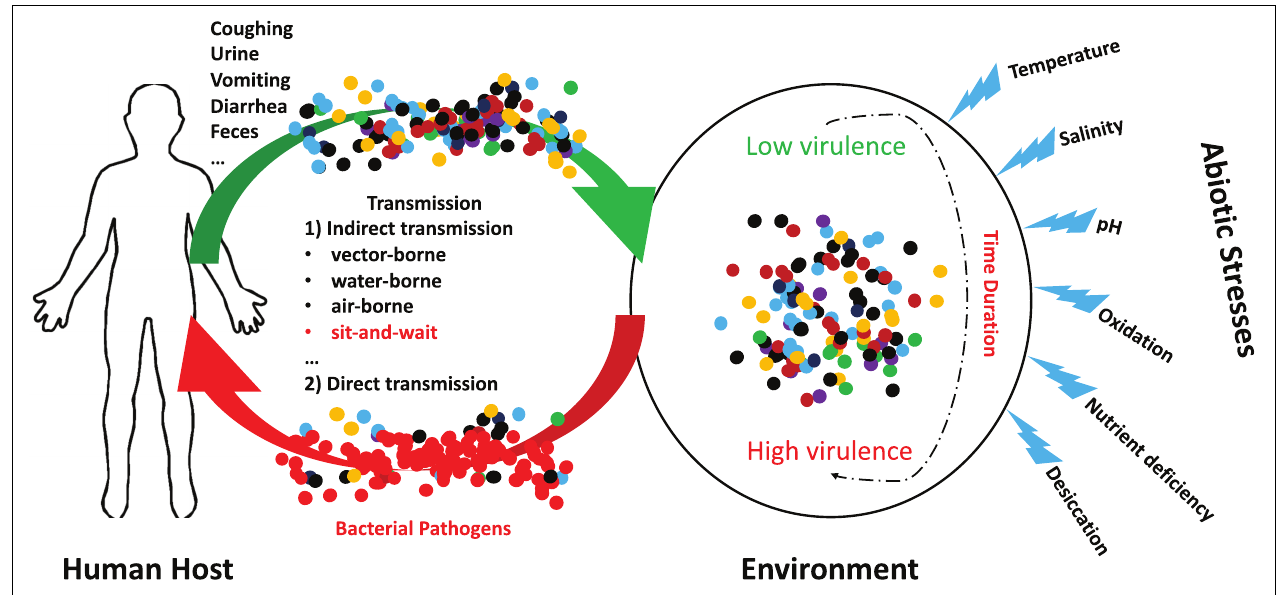
FIGURE 1 | Schematic illustration of the potential interactions between abiotic stress and bacterial pathogens. A group of indirectly transmitted bacterial pathogens shed from human hosts were spread to environment via a variety of routes, where they encounter many abiotic stresses for a certain duration. During the period, it is possible that bacterial pathogenic phenotypes could be altered from low virulence to high virulence due to the influences of abiotic stresses. These bacteria may cause severe consequences after being transmitted to new